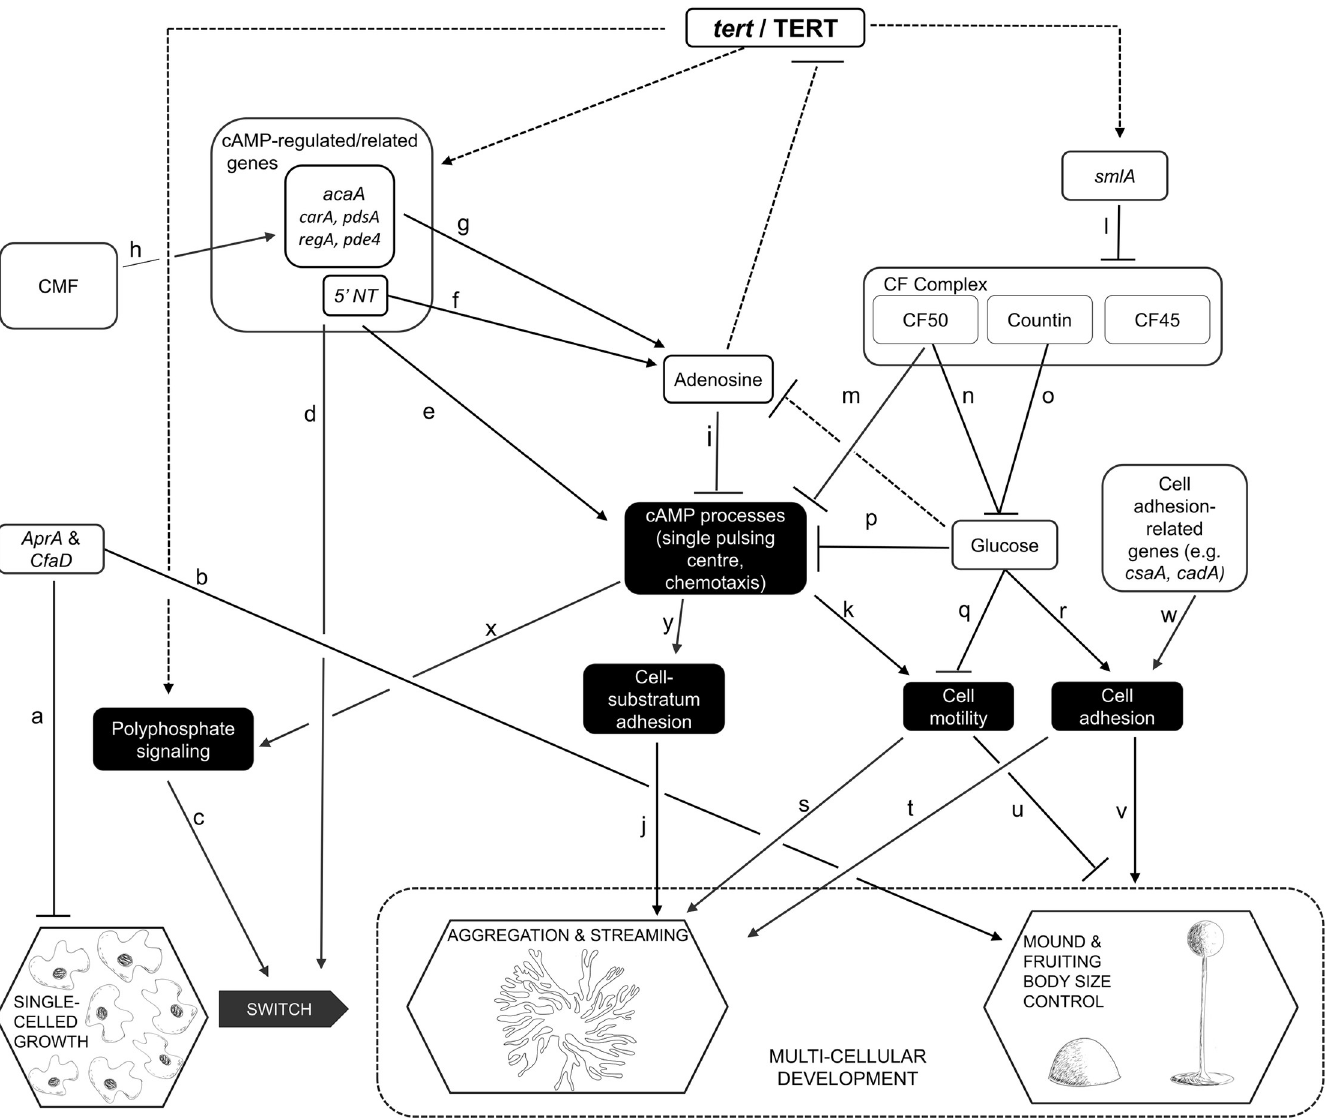
Fig 17. Some of the possible targets of tert /TERT in development of D . discoideum , as indicated by this study. This work, the first functional study of a telomerase in Dictyostelium , revealed that TERT influenced many previously reported developmental processes and pathways. The dashed lines represent effects previously unreported, involving multiples phases of the life-cycle. Adenosine, however, was found to provide negative feedback on tert expression. The letters next to the undashed lines are explained in the caption of Fig